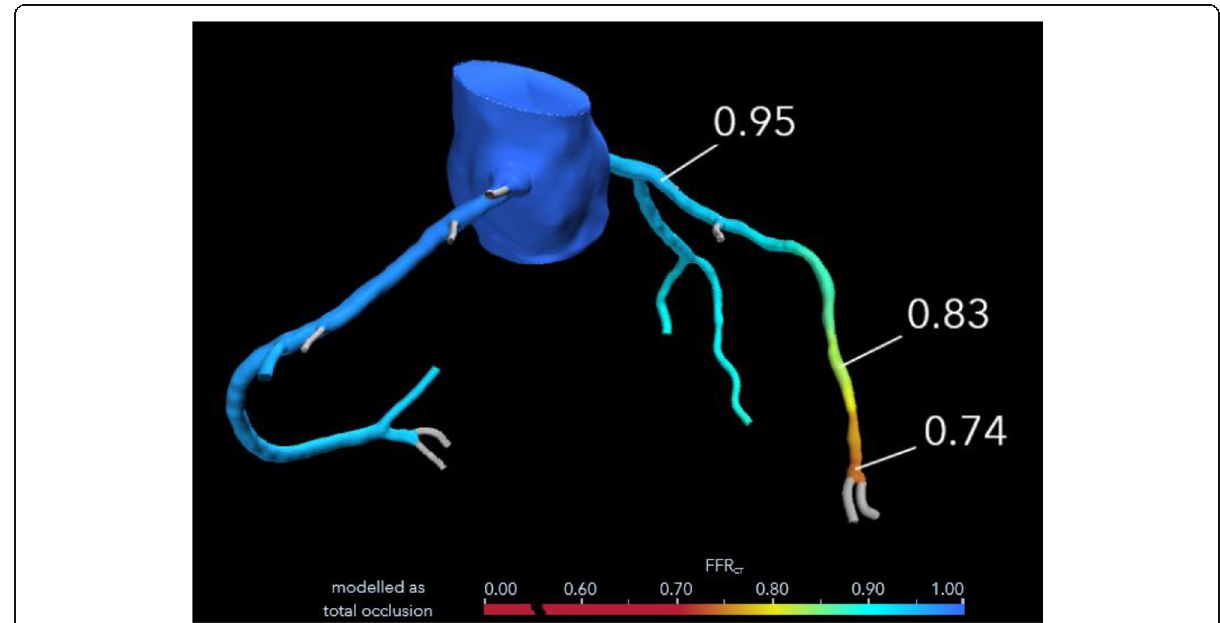
Fig. 5 CT coronary angiogram with CT-FFR indicates distal left anterior descending coronary artery (LAD) ischemia. Right anterior oblique-cranial projection